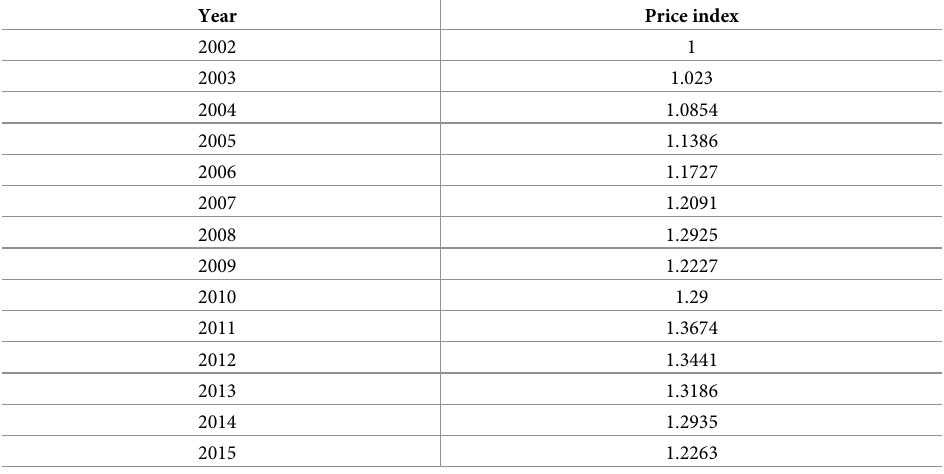
Table 5. The price conversion coefficient from 2002 to